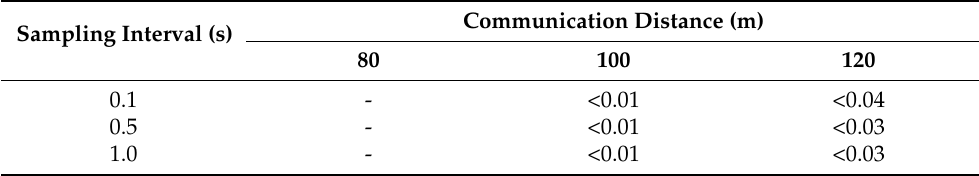
Table 4. The packet loss rate of the communication performance test.